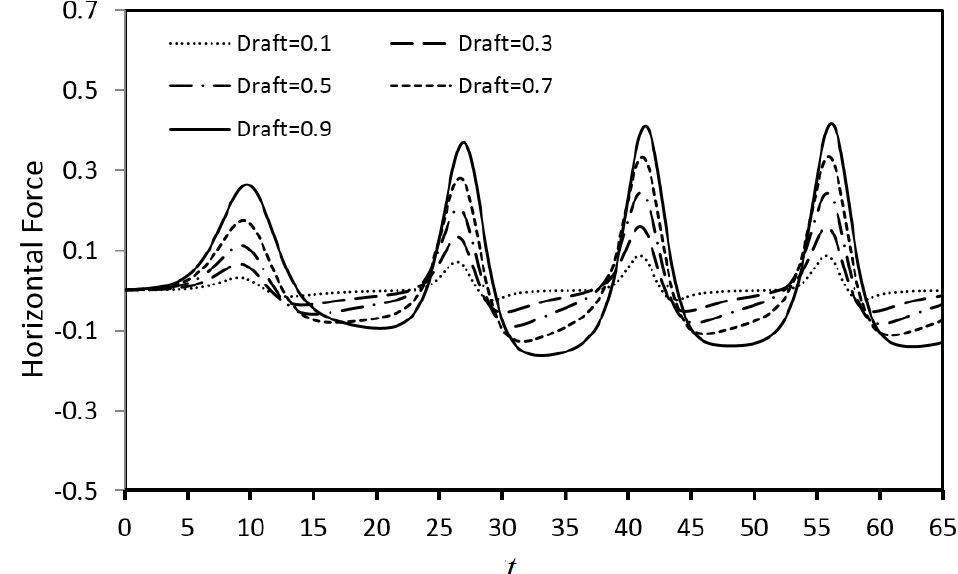
Figure 9. Time-series plots of horizontal force for various body draft conditions using the incident wave conditions of α = 0.3 and λ = 15. The body thickness is set as L = 4.